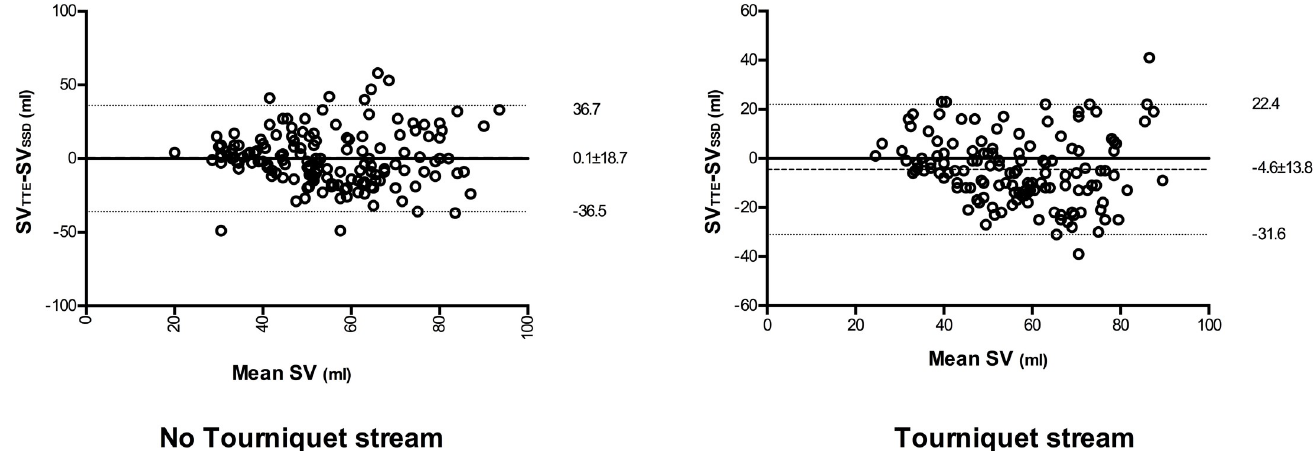
Fig 3. Bland-Altman plot comparing stroke volume (SV) values recorded using supra-sternal Doppler (SSD) and trans-thoracic echocardiography (TTE). Values indicate bias ± SD and 95% limits of agreement.